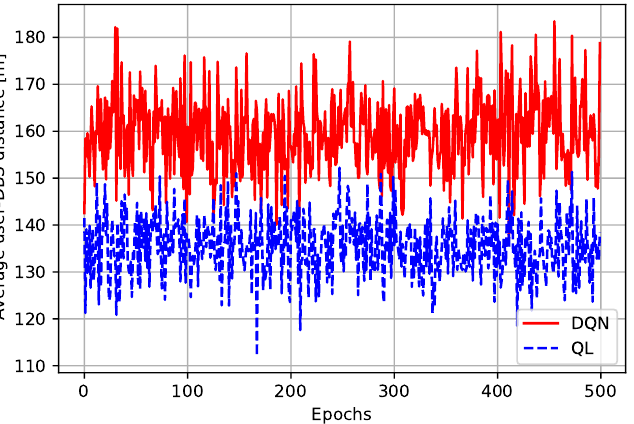
Figure 7. The average distance between the user and the Drone Base Station (DBS) in meter. The greedy models are also evaluated over 500 independent missions of 1000-transitions.